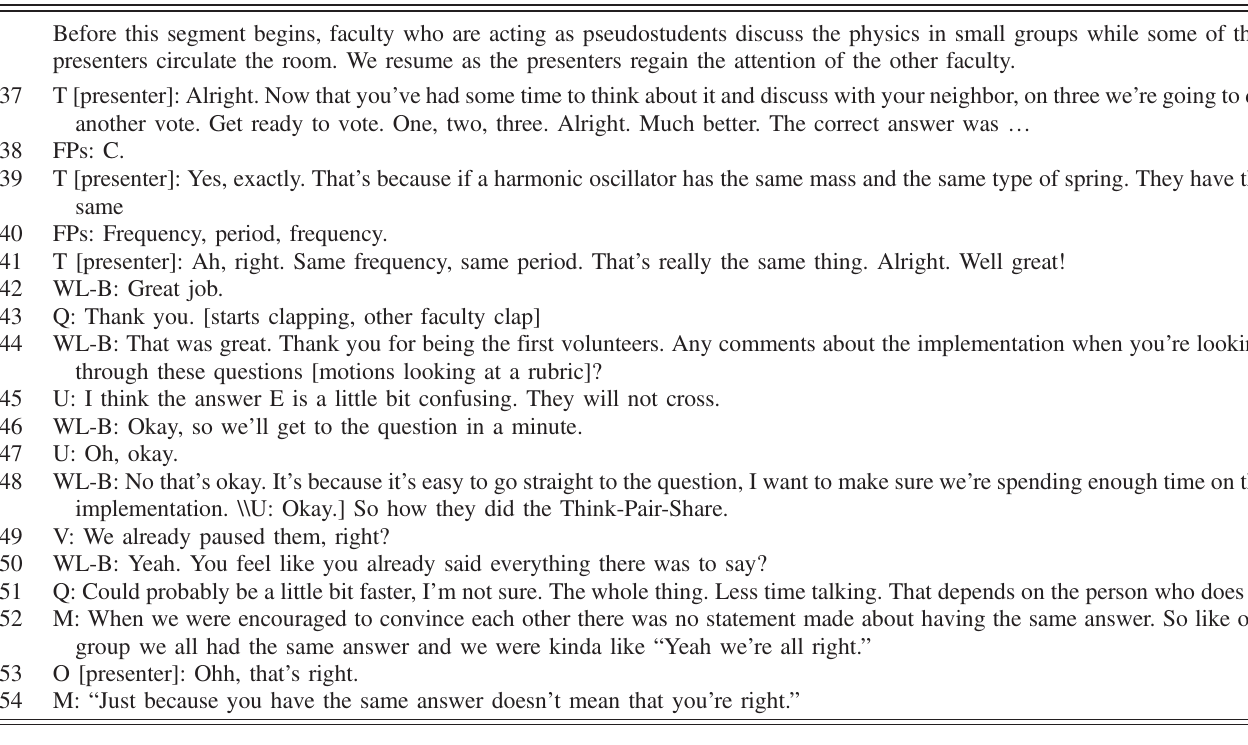
TABLE V. Continued transcript of the first group of presenters being paused and critiqued in Session B. As earlier, when faculty offer scripted words and phrases as suggestions or critiques, these words and phrases are indicated by quotation marks. When these